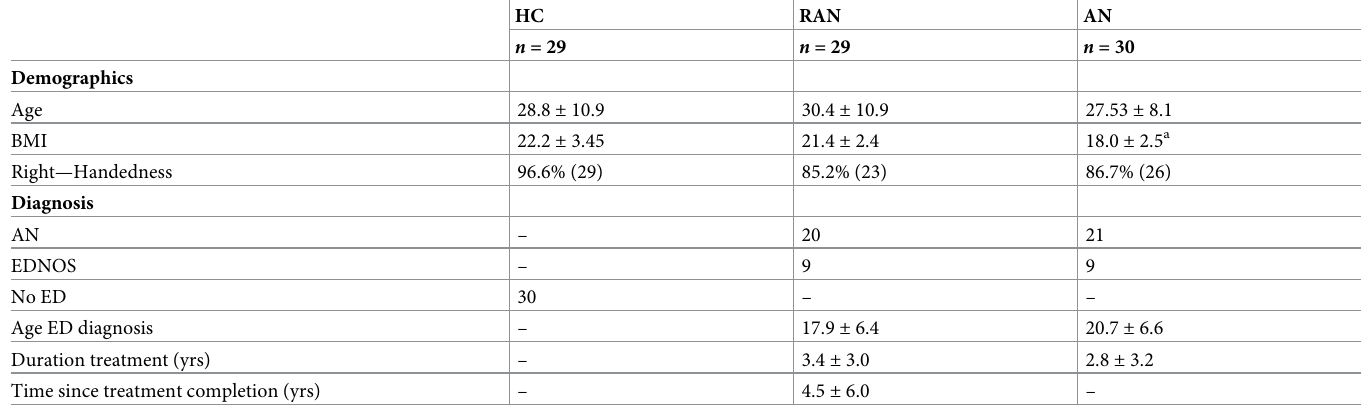
Table 1. Demographics and clinical